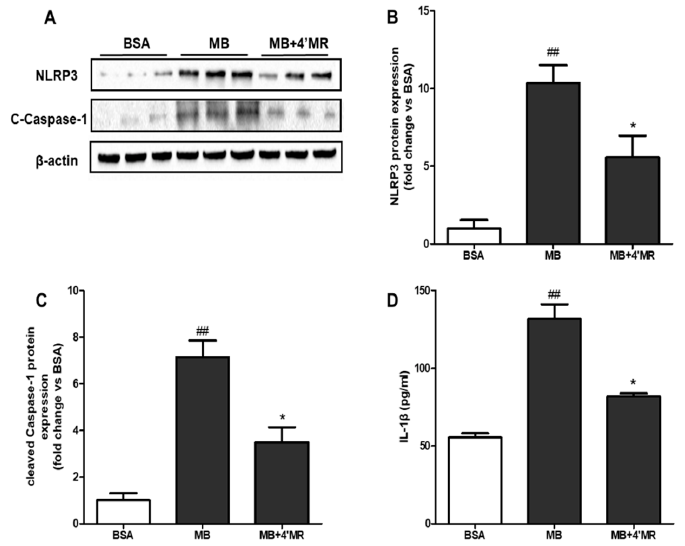
Figure 5. 4 ′ -Methoxyresveratrol counteracted NLRP3 inflammasome activation induced by MB in RAW264.7 macrophages. Cells were treated with 200 µg/mL BSA or MB with or without 10 µM 4 ′ MR for 24 h. ( A ) Representative Western blotting images of total NLRP3 and cleaved caspase-1 protein expression; ( B , C ) Quantification of fold-change of NLRP3 ( B ) and cleaved caspase-1 ( C ) protein expression; and ( D ) IL-1 β secretion was analyzed by ELISA in culture supernatant. All data are averages of triplicates from two separate experiments and shown as mean ± SD. ## p < 0.01 vs. BSA; * p < 0.05 vs. MB. 4 ′ MR, 4 ′ -Methoxyresveratrol.